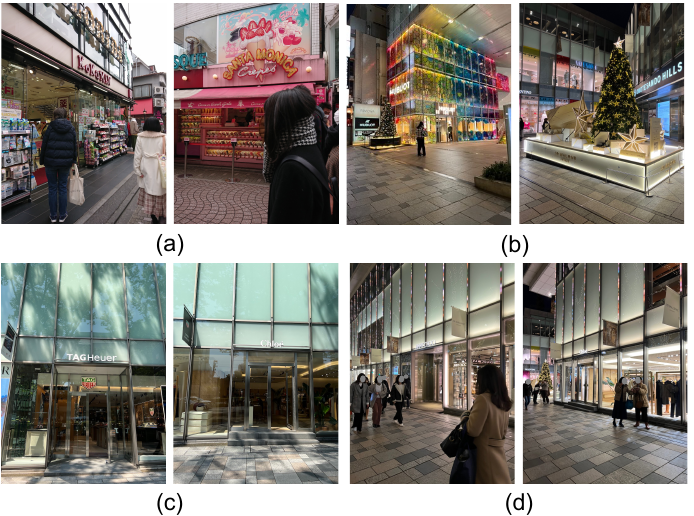
Figure 6. Examples from the TokyoPlaceText evaluation dataset: ( a ) General day-time images; ( b ) Night-time images including illumination and seasonal changes; ( c ) Perceptual aliased day time; ( d ) Perceptually aliased